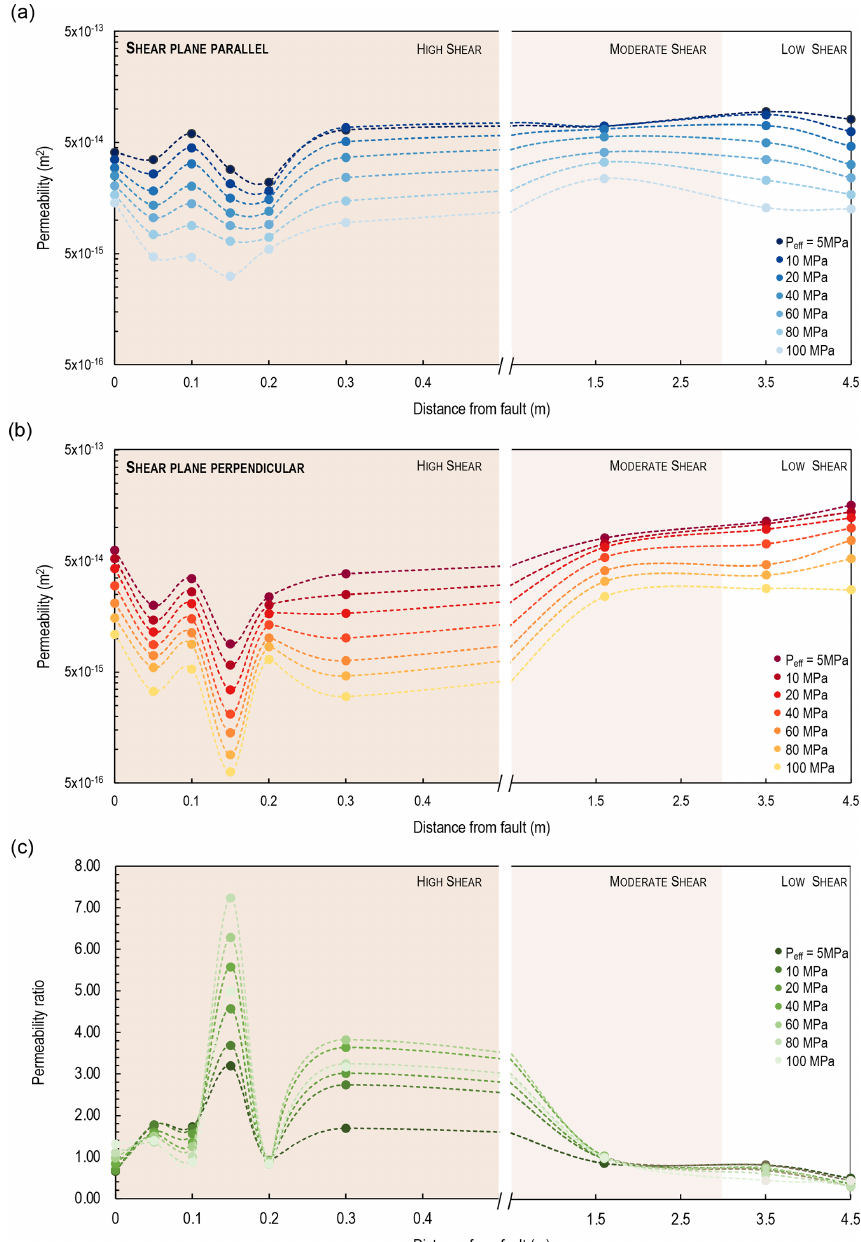
Figure 6. Permeability of the marginal shear zone as a function of effective pressure and direction to shear: measurements conducted (a) parallel and (b) perpendicular to the shear plane. The data show a reduction in permeability with effective pressure, yet the permeability profile across the shear zone remains, irrespective of the pressure conditions tested. The data show contrasting permeabilities as a function of direction, which create (c) permeability anisotropy, cast here as the ratio between the permeability parallel and perpendicular to the shear plane. The anisotropy is most pronounced in the high shear zone and generally increased as samples were loaded to higher effective pressure due to fracture closure. Note that the x axis was truncated and the scale was expanded for the near-fault high shear zone for which we conducted more measurements due to the structurally complex nature of this area of the spine. Measurements on the gouge sample are plotted at a distance of